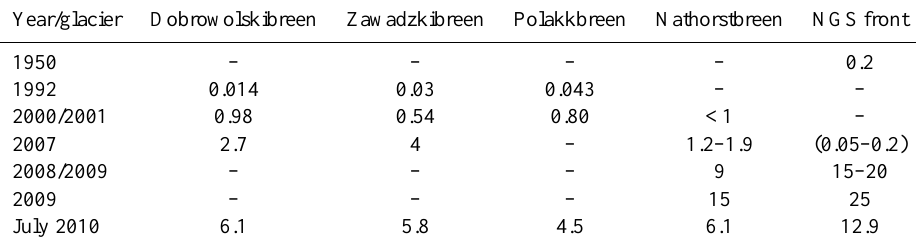
Table 1. Velocities during surge development. The highest observed velocities (md − 1 ) for each period at the different glaciers. The NGS front started to advance after October 2008 (stage